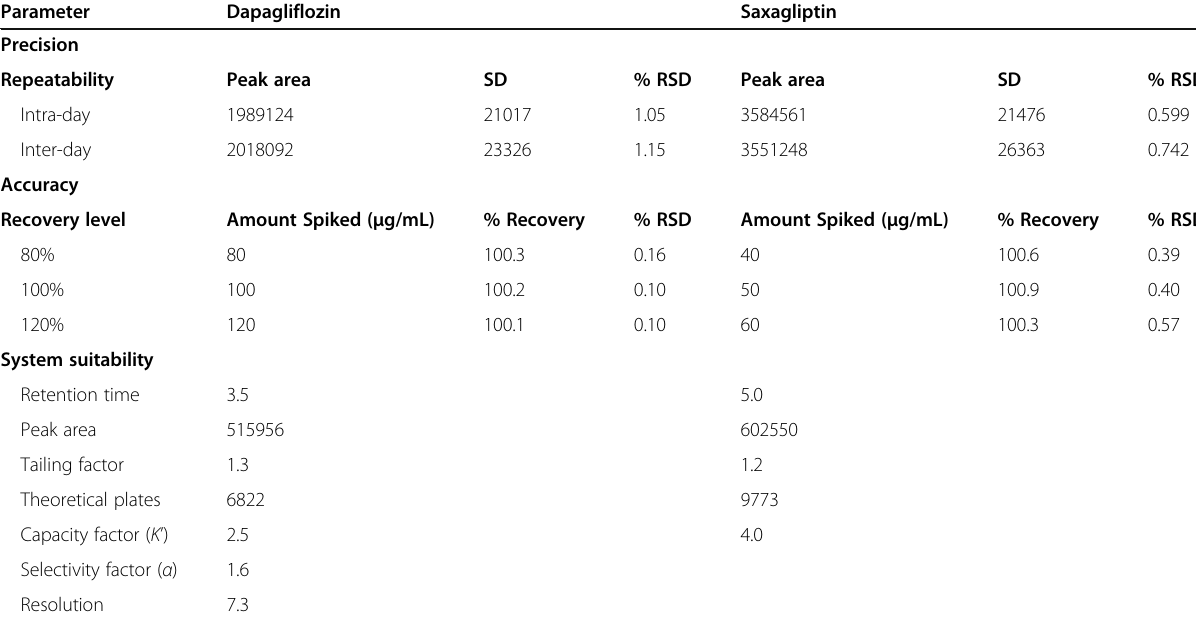
Table 3 Results of method validation